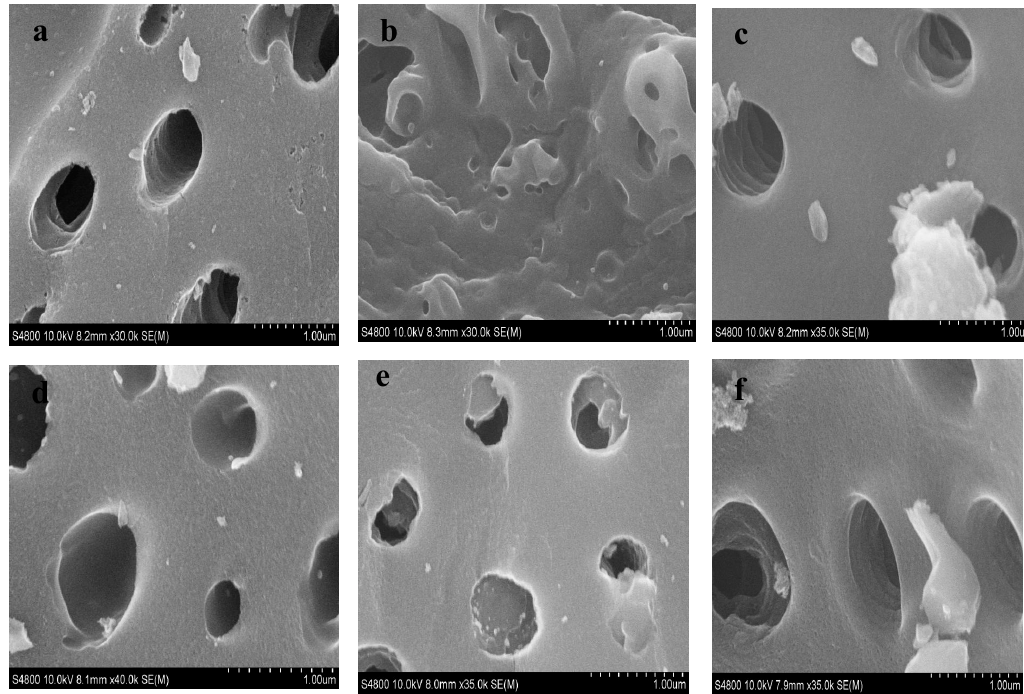
Figure 2. SEM image of the prepared activated carbon (AC) treated with regeneration after 0 ( a ), 2 ( b ), 4 ( c ), 6 ( d ), 8 ( e ), 10 ( f ) number of cycles.